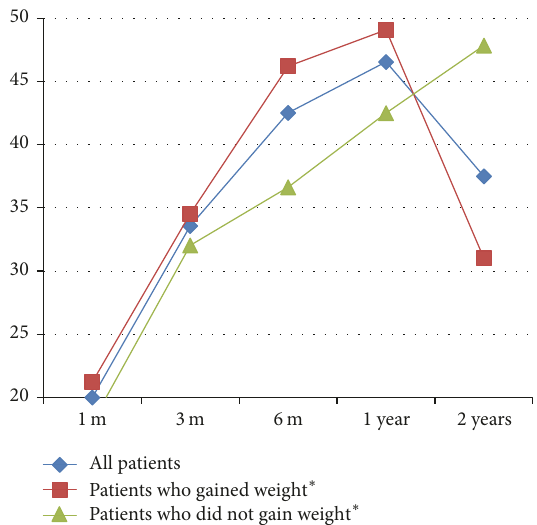
Figure 2: EWL% of 26 patients at 1, 3, 6, 12, and 24 months post- LGGCP. ∗ Patients who gained weight = 16 and patients who did not gain weight = 9